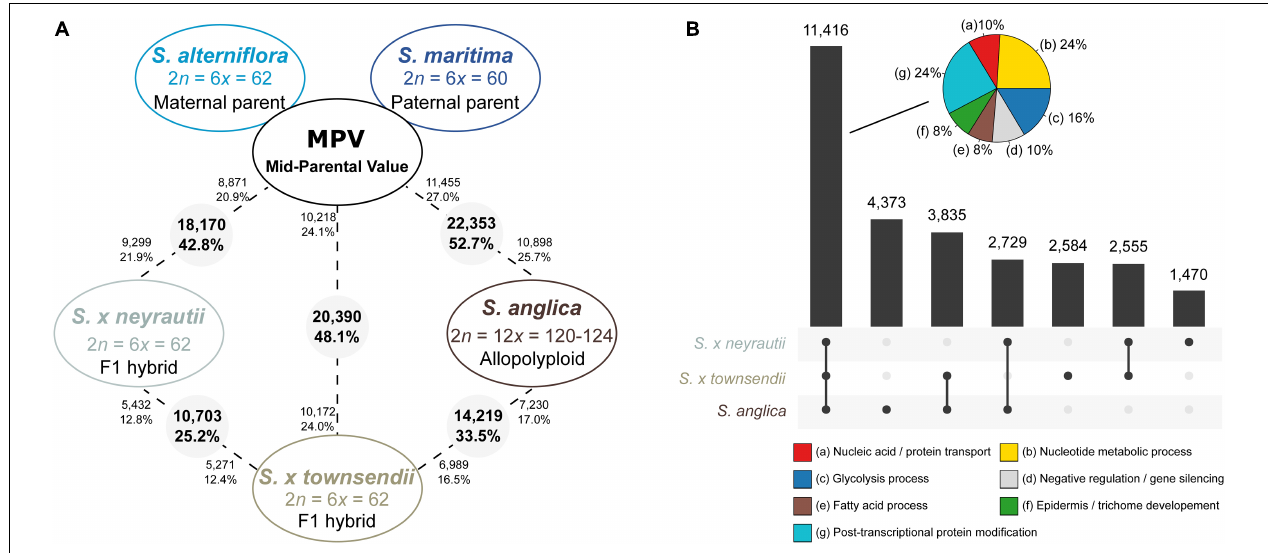
FIGURE 4 | Transcriptomic changes in F1 hybrids and the allopolyploid species compared to the in silico MPV (mid-parent value). (A) The number (and percentages) of differentially expressed (DE) genes between the MPV (expression expected under additive parental expression) and the F1 hybrids ( S. × townsendii and S. × neyrautii ) or the allopolyploid S. anglica are provided. The numbers in grey circles represent the number of orthologs differentially expressed among the 42,423 analyzed clusters. The numbers of upregulated orthologs are represented near species names. (B) Diagram of common DE genes between the MPV and species deriving from recent allopolyploidization. Pie charts represent enriched metabolic pathways within 11, 416 genes found DE compared to the MPV both among S. × townsendii, S. × neyrautii, and S. anglica (% of genes associated with enriched metabolic pathways). The complete list of enriched GO terms is available